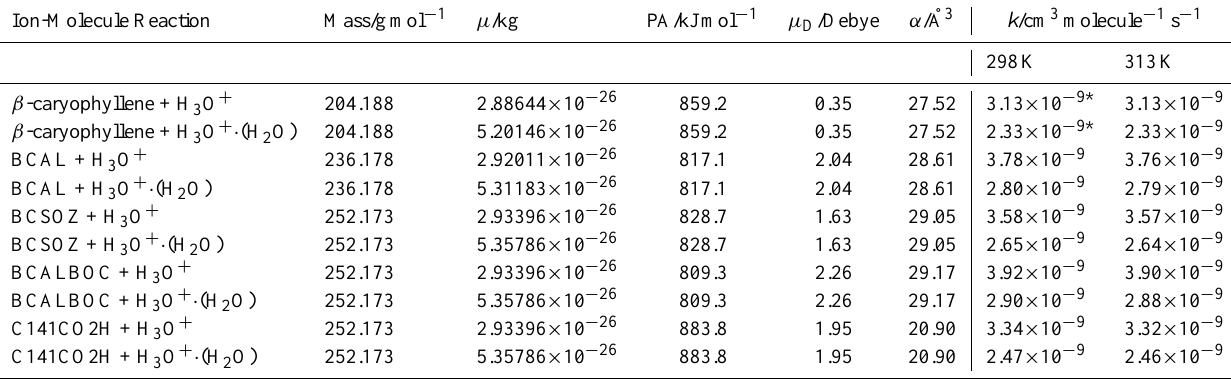
Table 2. Proton affinities (PA), dipole moments ( µ D ), polarizabilities ( α ) and proton transfer reaction rate coefficients ( k ) calculated for β -caryophyllene and selected oxidation products that potentially contribute to the major CIR-TOF-MS product ions, m / z 253 and m / z 237. Organic reagent masses and reduced reagent molecular masses ( µ ) are also